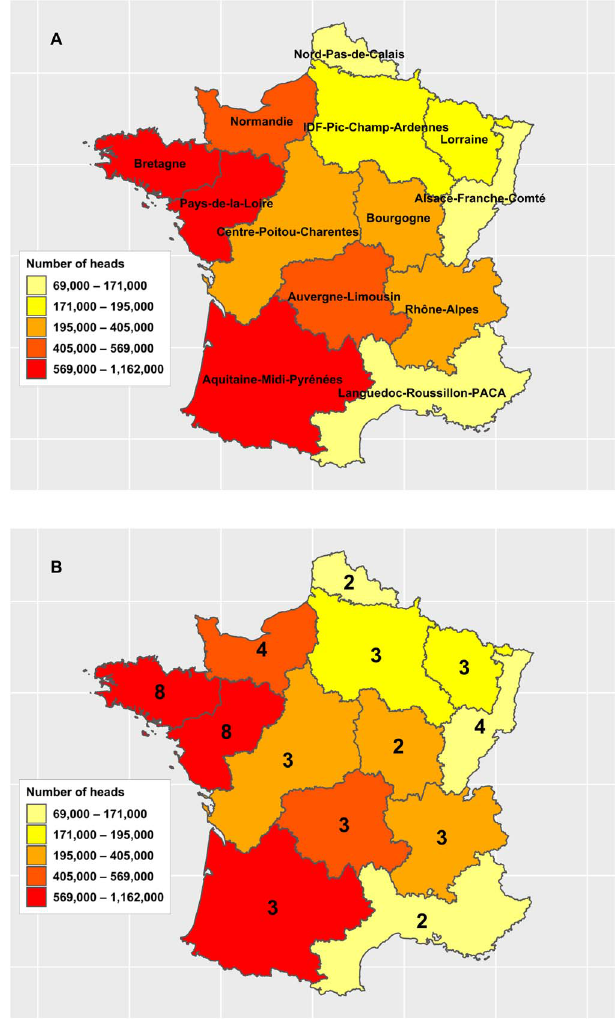
Figure 1. (A) Map of French beef production according to the Ministry of Agriculture database. The colour gradient represents the number of cattle slaughtered in 2007. (B) The numbers represent the number of slaughterhouses per region that were included in the cross-sectional survey of Toxoplasma gondii presence in beef produced in